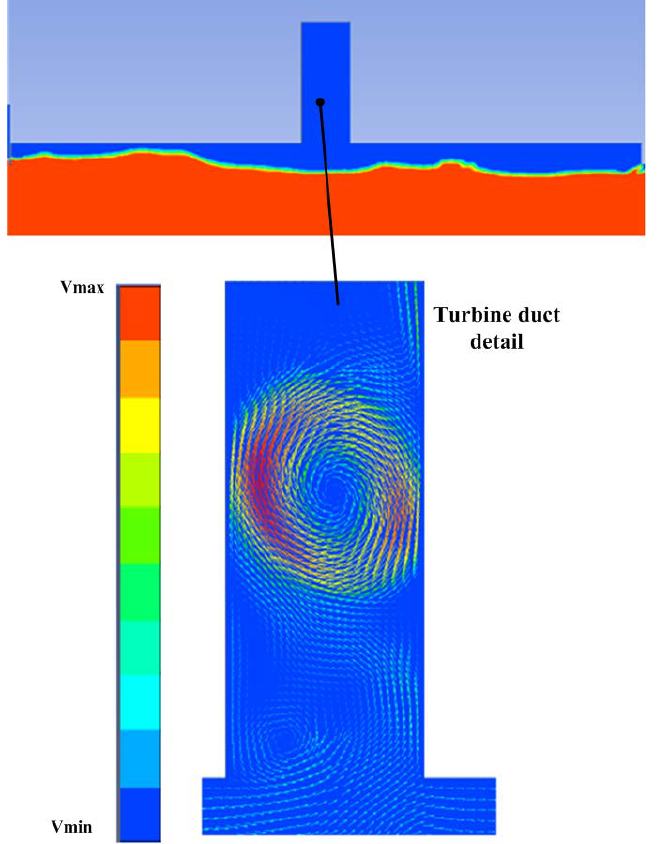
Figure 11. Device model with water (red) and air (blue) and the turbine duct detail, with air recir- culation and its maximum (7.198761 m/s ) a nd minimum (−0 .007744 m/s ) velocity.